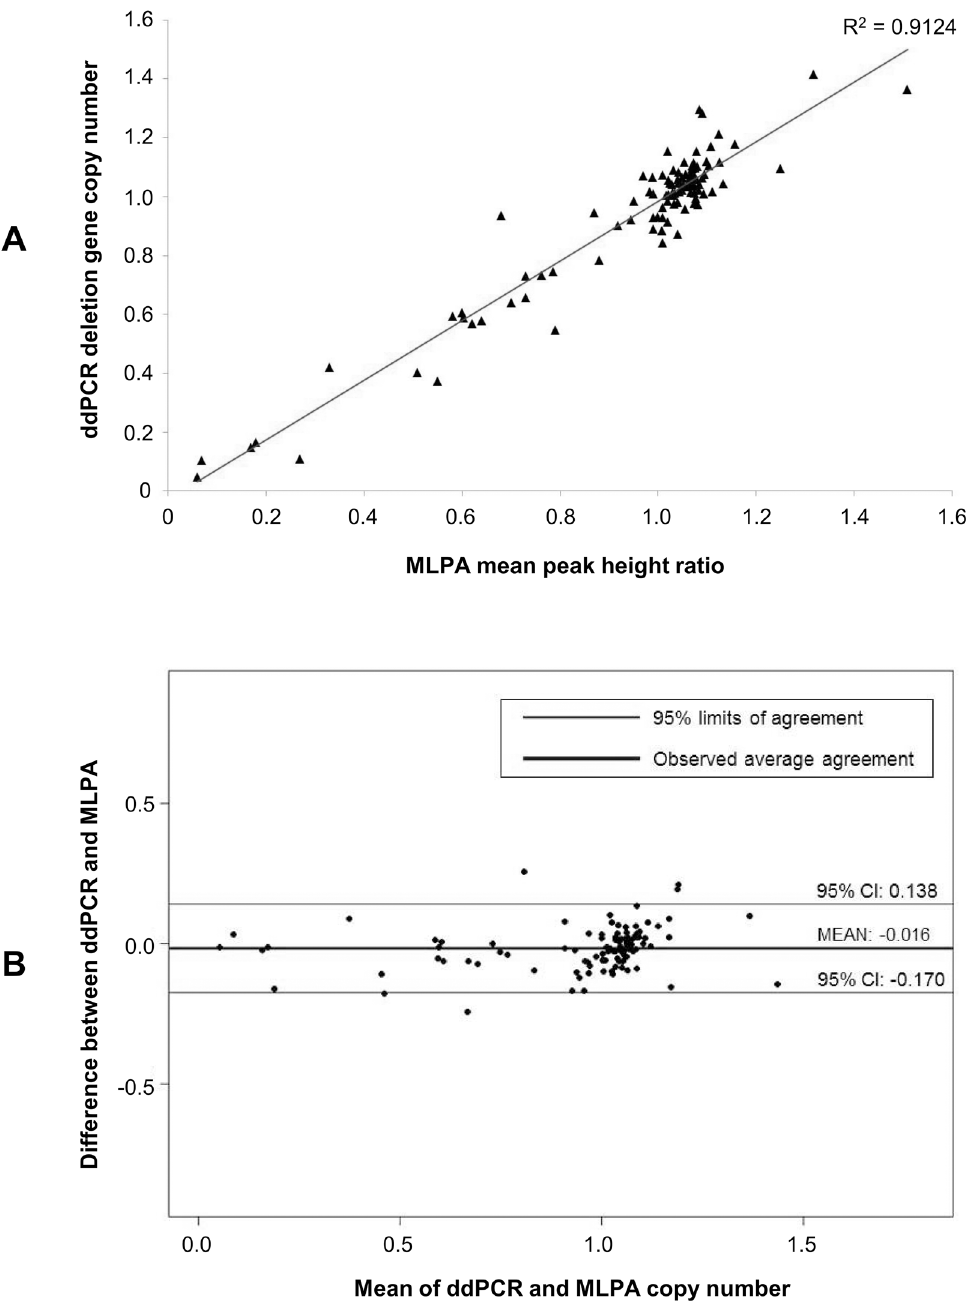
Fig 4. Comparison between deletion gene copy number measurements made by SMART-ddPCR and MLPA. Copy number measurements were available from ddPCR and MLPA assays for SNPs at the two deletion genes CDKN2A (SNP rs3731249) and IKZF1 (SNP rs4132601) in 27 and 75 tumor DNA samples respectively. (A) High correlation (R2 = 0.91) between the combined deletion gene copy number measurements made by ddPCR and MLPA. (B) Bland-Altman plot displaying the difference between measurements made in the same individual against their mean, as measured by two different methodologies ( i . e . ddPCR and MLPA). There is very close agreement between the copy number measurements made by the two assays, as demonstrated by the narrow limits of agreement (-0.170 to 0.138) either side of the observed average agreement (-0.016).